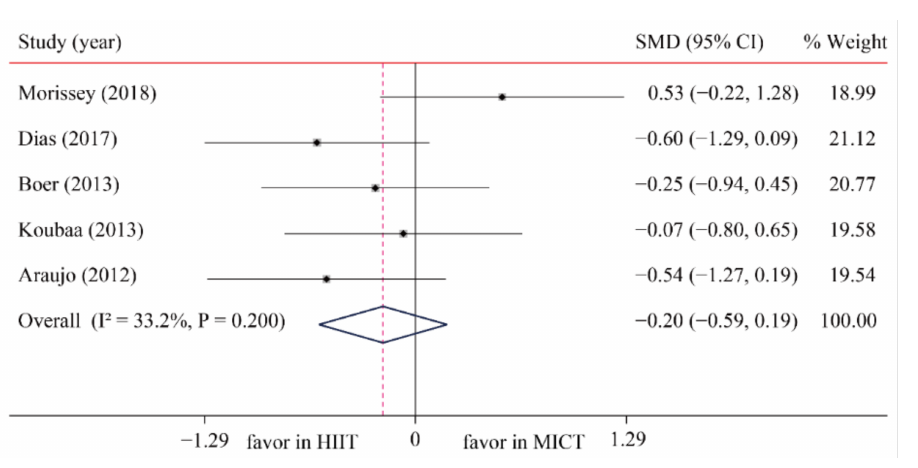
Figure 10. Effect of HIIT versus MICT on triglycerides.